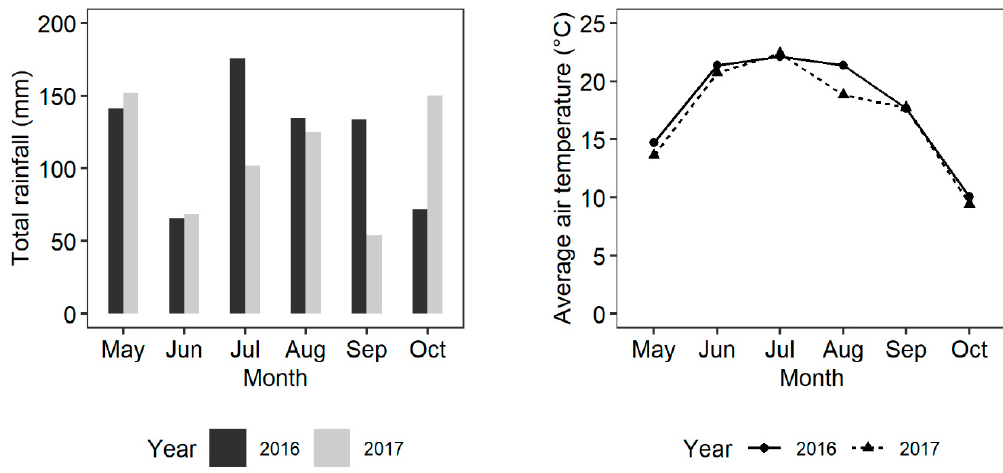
Figure 3. Total monthly rainfall and monthly average air temperature during 2016 and 2017 growing seasons at the study site.